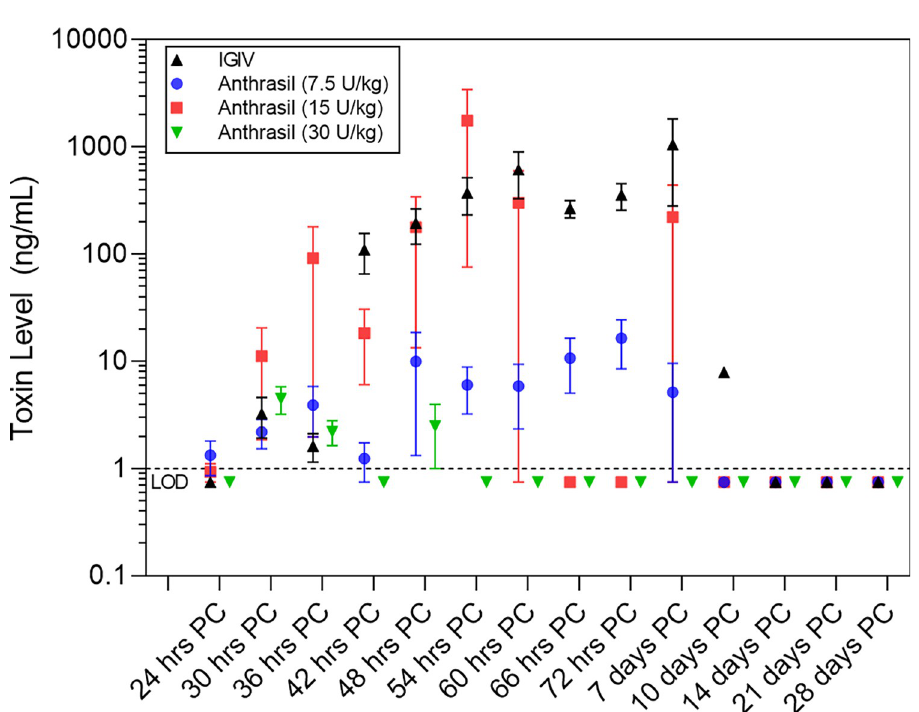
Fig 4. Mean toxin levels in B . anthracis -infected nonhuman primates treated with IGIV or three different doses of ANTHRASIL. Plot of geometric means of toxin levels and 95% confidence intervals over time on the log-scale in B . anthracis spore-challenged NHPs that received a full dose of IGIV or one of three doses of ANTHRASIL and were bacteremic at least once prior to treatment (Modified-intent-to-treat analysis set). Animals were treated following the detection of toxemia, which was observed from 24 h to 54 h post-challenge, and infusions began within 6 h (approximately 30 h to 60 h post-challenge).